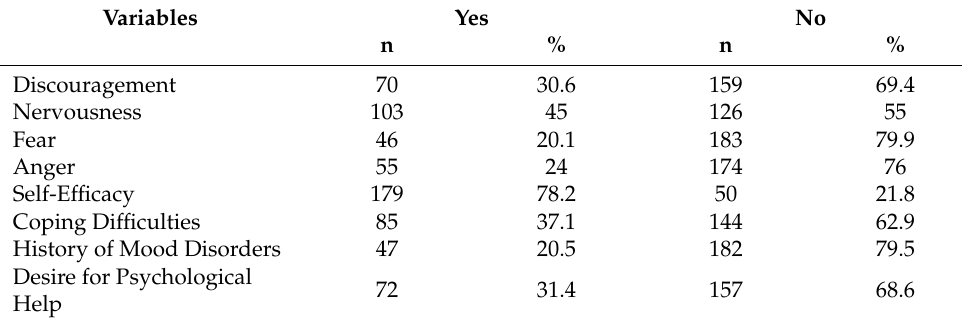
Table 2. Psychological characteristics of the subsample (n = 229).